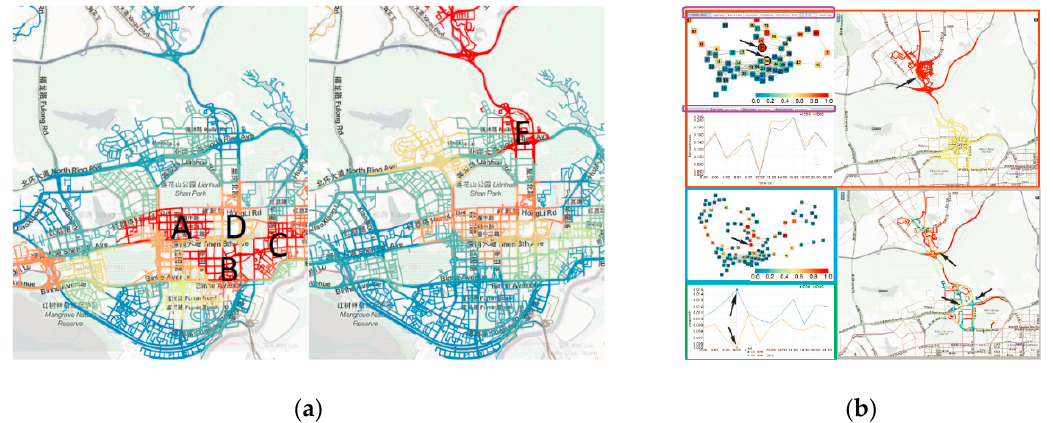
Figure 19. TrajGraph visualization [53]: ( a ) filtering preferred hub regions; and ( b ) locating urban bottleneck areas.